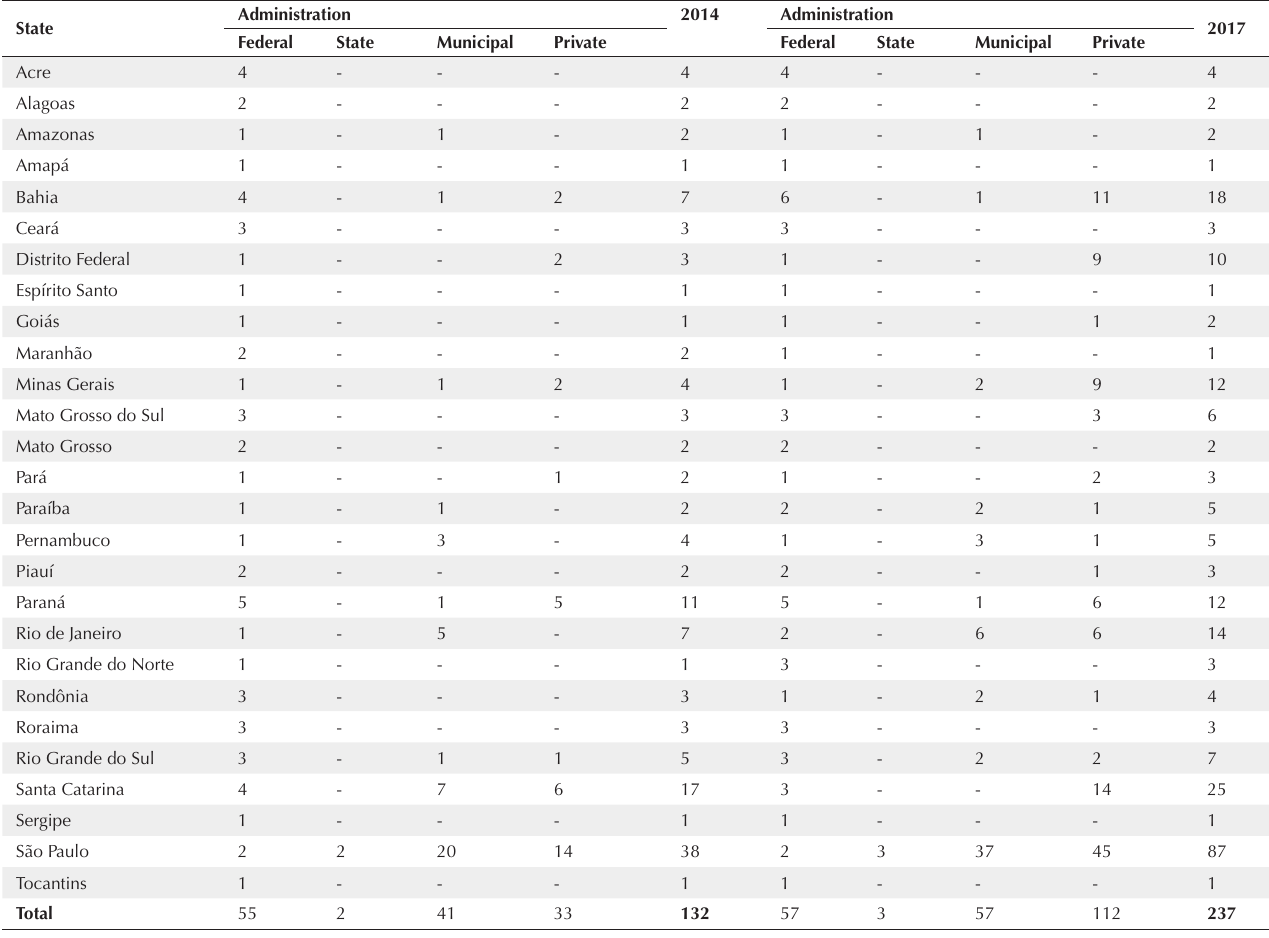
Table 1 . Travel Medicine Clinics - Brazil (2014/2017)